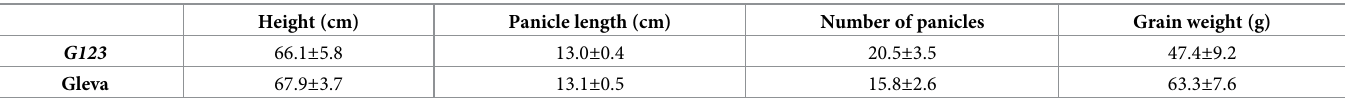
The expression of the flowering regulatory genes is altered in the G123 mutant The daily expression pattern of the main genes involved in the photoperiod regulation of flow- ering in the Gleva and G123 plants reflected their flowering phenotype differences (Fig 3). Table 1. Phenotypic characteristics of the Gleva and G123 plants. Height, panicle length, number of panicles and grain weight per plant are